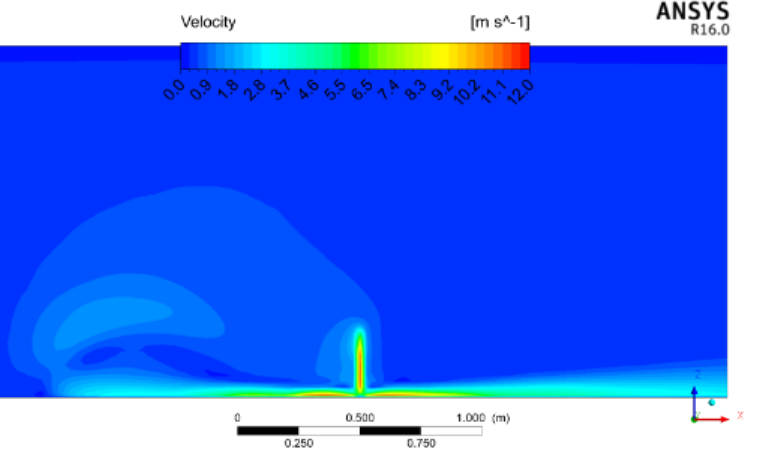
Figure 21. Time 1.6 s contour of the air velocity.